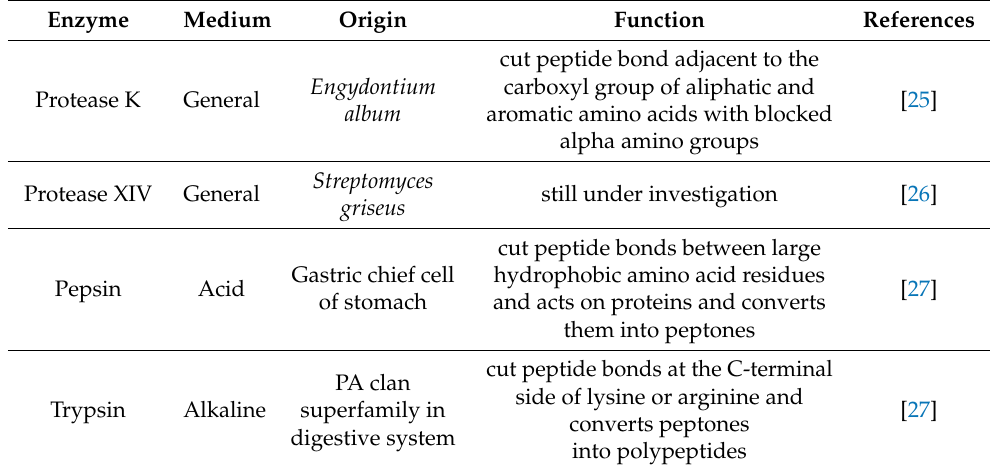
Table 1. Property of enzymes involved in this